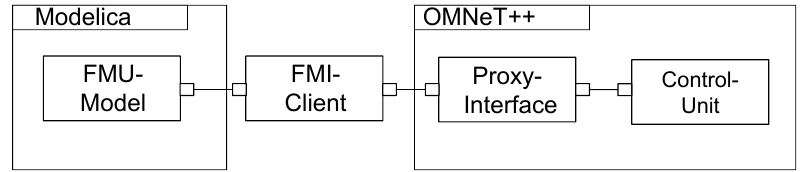
Figure 7. Architecture for co-simulation of OMNeT++ and